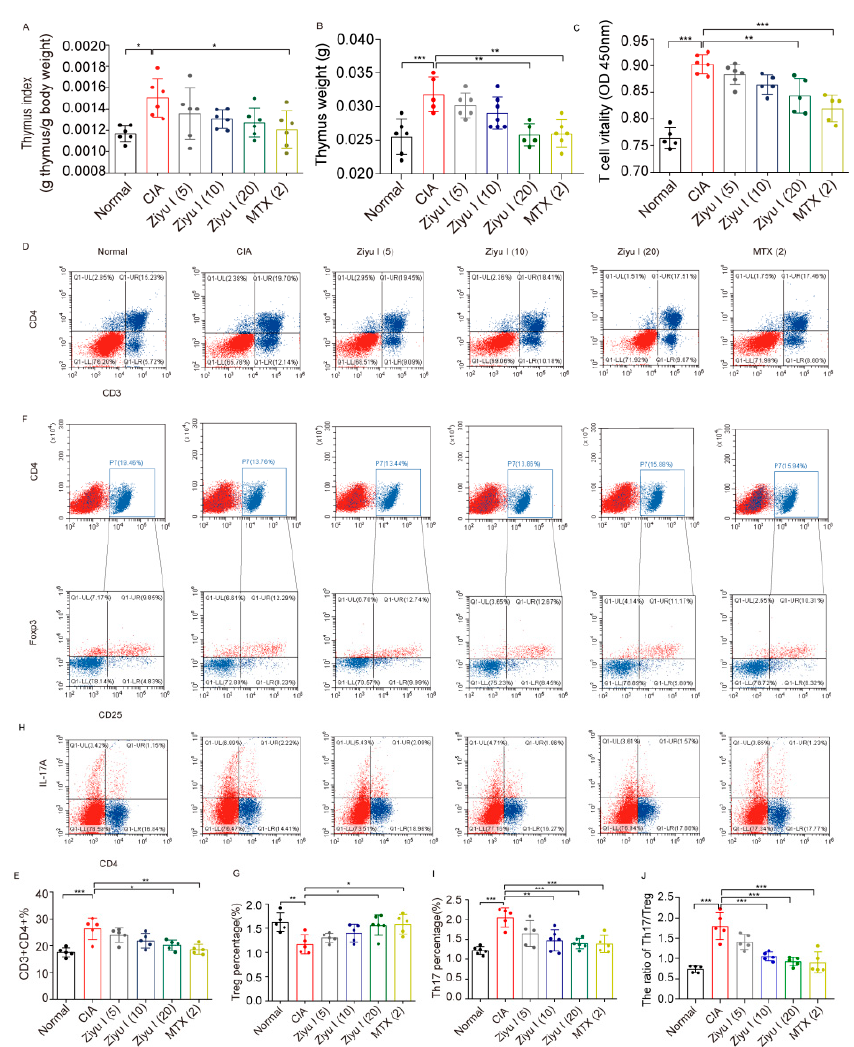
Figure 3. Ziyu I treatment reduces thymus pathology and the proportion of Th17 cells in CIA mice. ( A ). The thymus index (g thymus/g body weight) of treated CIA mice was calculated ( B ). Thymus weight (g) ( C ). T cells vitality was tested by CCK-8 ( D ). Representative flow cytometry scatter plot of CD3+CD4+ Th cells ( E ). The percentage of Th cells was analyzed ( F ). Representative flow cytometry scatter plot of CD4+CD25+Foxp3+ Treg cells ( G ). The percentage of Treg cells was analyzed ( H ). Representative flow cytometry scatter plot of Th17 cells ( I ). The percentage of Th17 cells was analyzed ( J ). The ratio of Th17/Treg cells was analyzed. * p < 0.05, ** p < 0.01, *** p < 0.001 vs. CIA. (n = 5–6, mean ± SD).